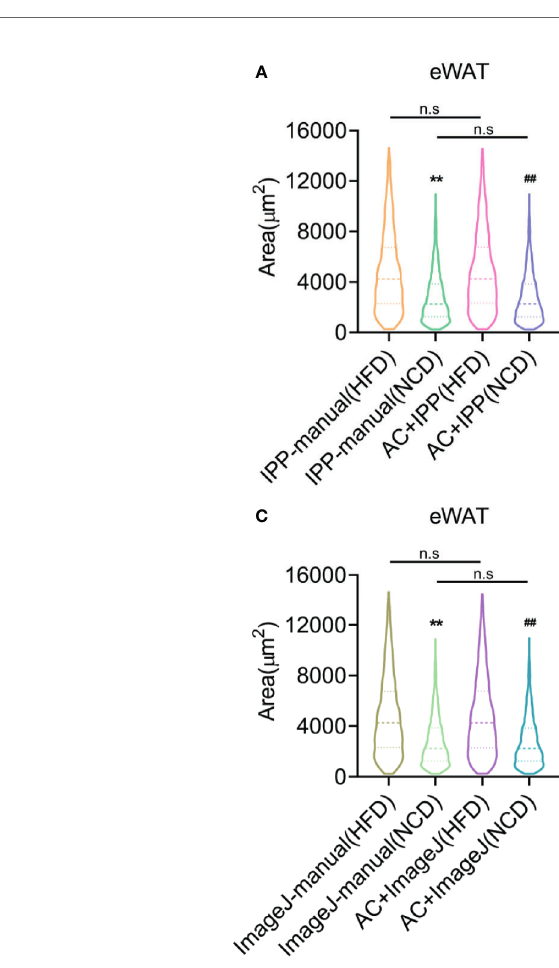
FIGURE 7 | Adipocyte counting by the combined methods yields comparable data as manual methods but saves more time. (A, B) Adipocyte sizes measured by manual methods with IPP and combined methods with IPP and AdipoCount, in eWAT (A) and iWAT (B) . (C, D) Adipocyte sizes measured by manual methods with ImageJ and combined methods with ImageJ and AdipoCount, in eWAT (C) and iWAT (D) . Data are presented as mean ± SEM and **P < 0.01 compared to manual methods group. ## P < 0.01 compared to combined methods group. n.s, no signi fi cant. IPP, Image-Pro Plus; AC,